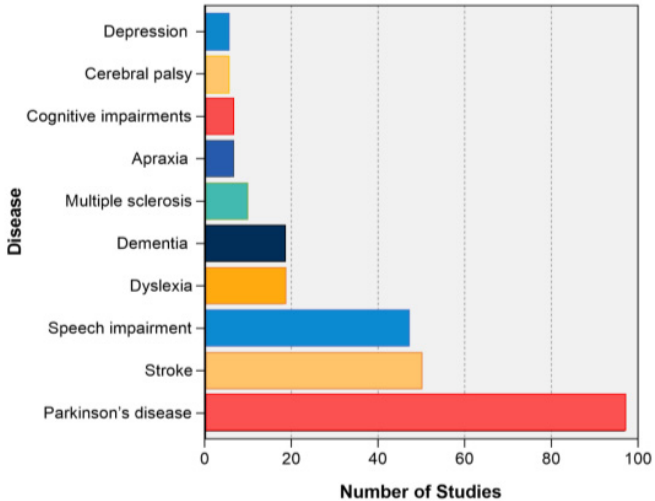
Figure 6. Top 10 most-focused diseases in rhythmic auditory stimulation research. Alt text: A bar chart demonstrates the ten most focused diseases within rhythmic auditory stimulation research between 2001–2020. Parkinson’s disease, stroke, and speech impairment received most attention for the 20 years.